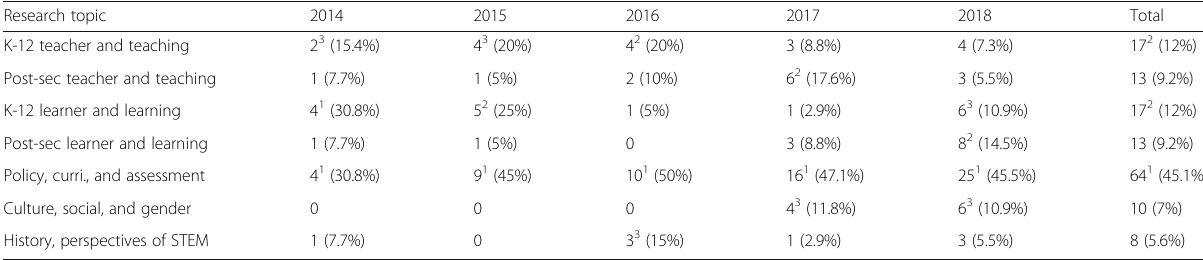
Table 5 Frequencies and percentages of research topic distributions over the 5 years Research